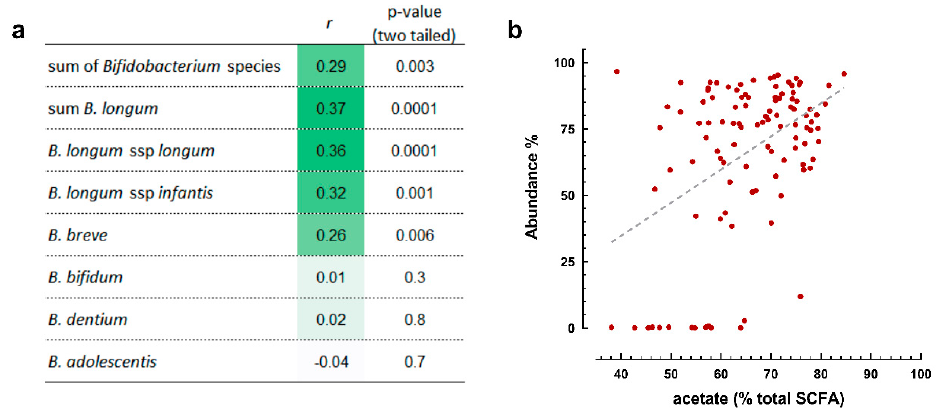
Figure 4. Association between relative acetate and Bifidobacterium species in infant stool samples. ( a ) Spearman correlation; ( b ) linear regression analysis of the sum of Bifidobacterium species and relative amounts of acetate.